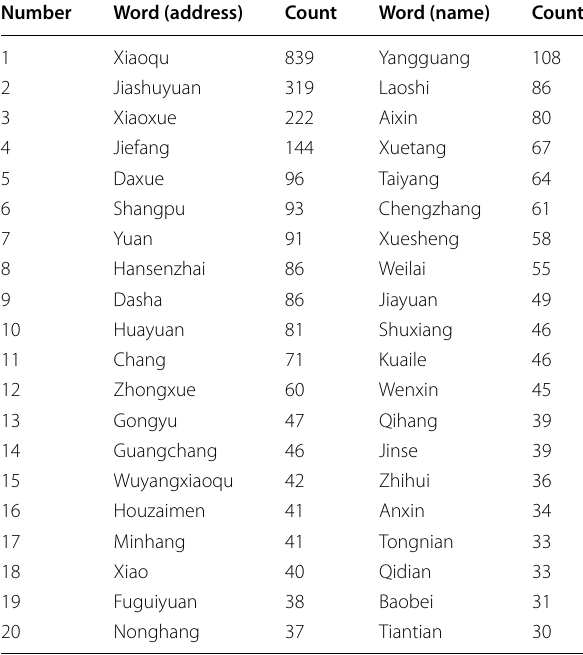
Table 1 Statistics on the address and name of